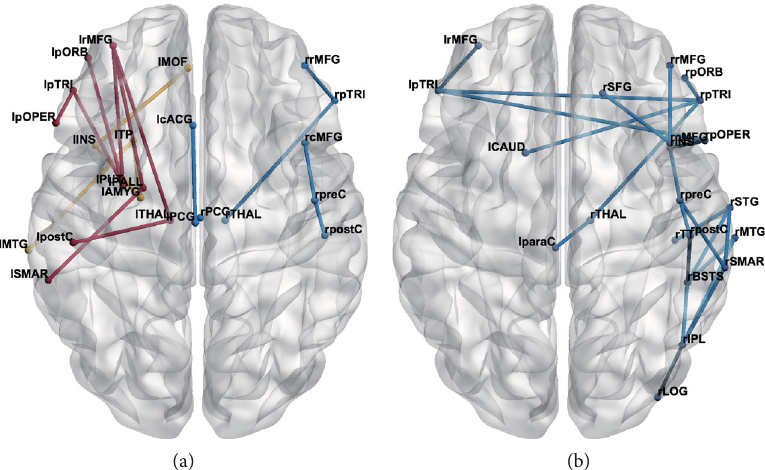
Figure 5: Altered structural connectivity derived from the network-based statistic. (a) An initial p < 0 : 005 resulted in three subnetworks color-coded in blue exhibiting decreased structural connectivity and two subnetworks color-coded in red/orange exhibiting enhanced structural connectivity in patients relative to normal controls. (b) An initial p < 0 : 05 resulted in a subnetwork color-coded in blue exhibiting decreased structural connectivity in patients relative to normal